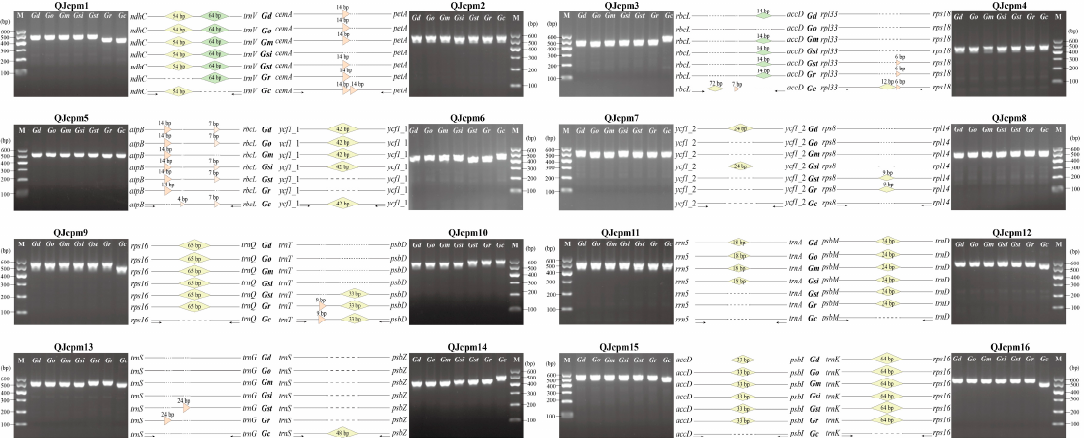
Figure 6. Validation of 16 molecular markers derived from InDel regions of eight chloroplast genomes of Gentiana sect. Cruciata . Inserted sequences and tandem repeats are designated by diamonds and triangle, respectively. Solid and dotted lines indicate conserved and deleted sequences, respectively. Left and right black arrows indicate forward and reverse primers, respectively. Abbreviated species names were shown on schematic diagrams: Gd , G. dahurica ; Go , G. officinalis ; Gm , G. macrophylla ; Gsi , G. siphonantha ; Gst , G. straminea ; Gr , G. robusta ; Gc , G. crassicaulis ; M, D600 DNA